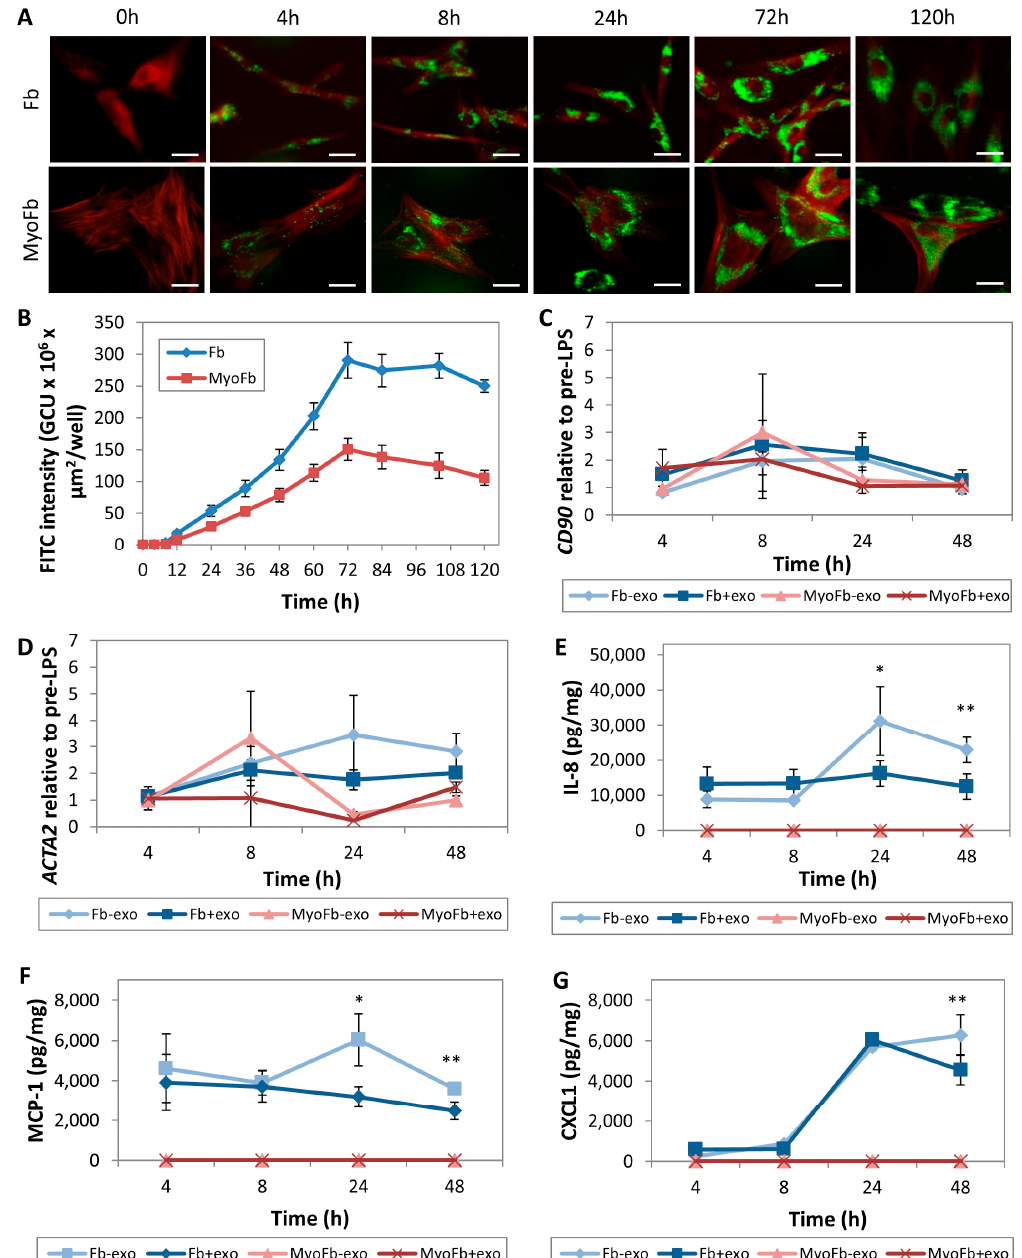
Figure 1. MSC-exo uptake by corneal stromal fibroblast (Fb) and myofibroblast (MyoFb) cultures and the cellular immunomodulatory effects. ( A ) Cellular uptake of AlexaFluor 488-tagged MSC-exo (green fluorescence) by cultured fibroblasts (CD90/Thy-1-positive; red fluorescence) and myofibroblasts ( α -SMA-positive; red fluorescence). Scale bars: 50 µ m. ( B ) The internalization of AlexaFluor 488-tagged MSC-exo was quantified by measuring the fluorescence intensity changes over 120 h using an IncuCyte live-cell system. ( C , D ) The immunomodulatory and anti-fibrotic effects of MSC-exo treatment on fibroblast and myofibroblast cultured were studied by target gene expression by RT-PCR. Expression fold change of CD90 ( C ) and ACTA2 ( D ) in fibroblast and myofibroblast cultures at 4, 8, 24, and 48 h after LPS treatments with or without MSC-exo. ( E – G ) The multiplex immunoassay showed the secretion of IL-8 ( E ), MCP-1 ( F ), and CXCL1 ( G ) from fibroblasts at 4, 8, 24, and 48 h treatments with (+exo) or without MSC-exo (-exo). Myofibroblast culture did not express any of the analyzed cytokines and chemokines. * p < 0.05; ** p <